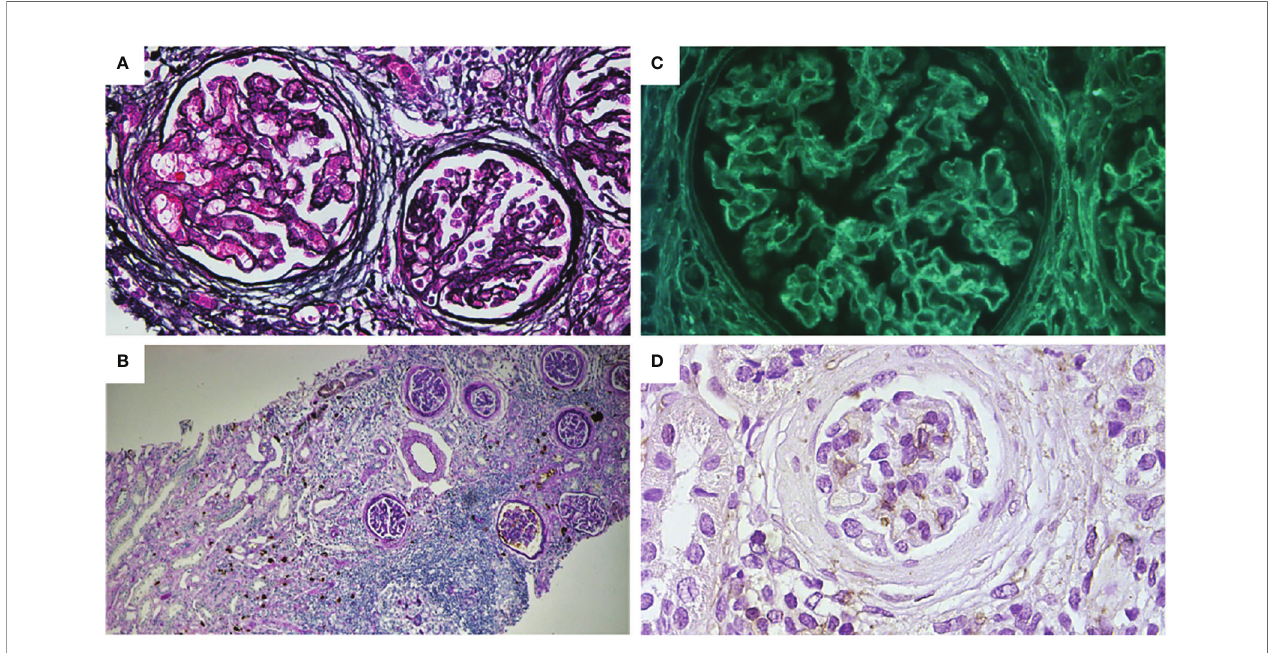
FIGURE 3 | (A) Mild thickening of the capillary wall and glomerular basement membrane. Bowman capsule enlargement and reduplication (periodic Schiff- methenamine silver, original magni fi cation: ×400). (B) Interstitial and peri-tubular IgG4 deposits. Mild tubular atrophy and interstitial fi brosis. Moderate focal and